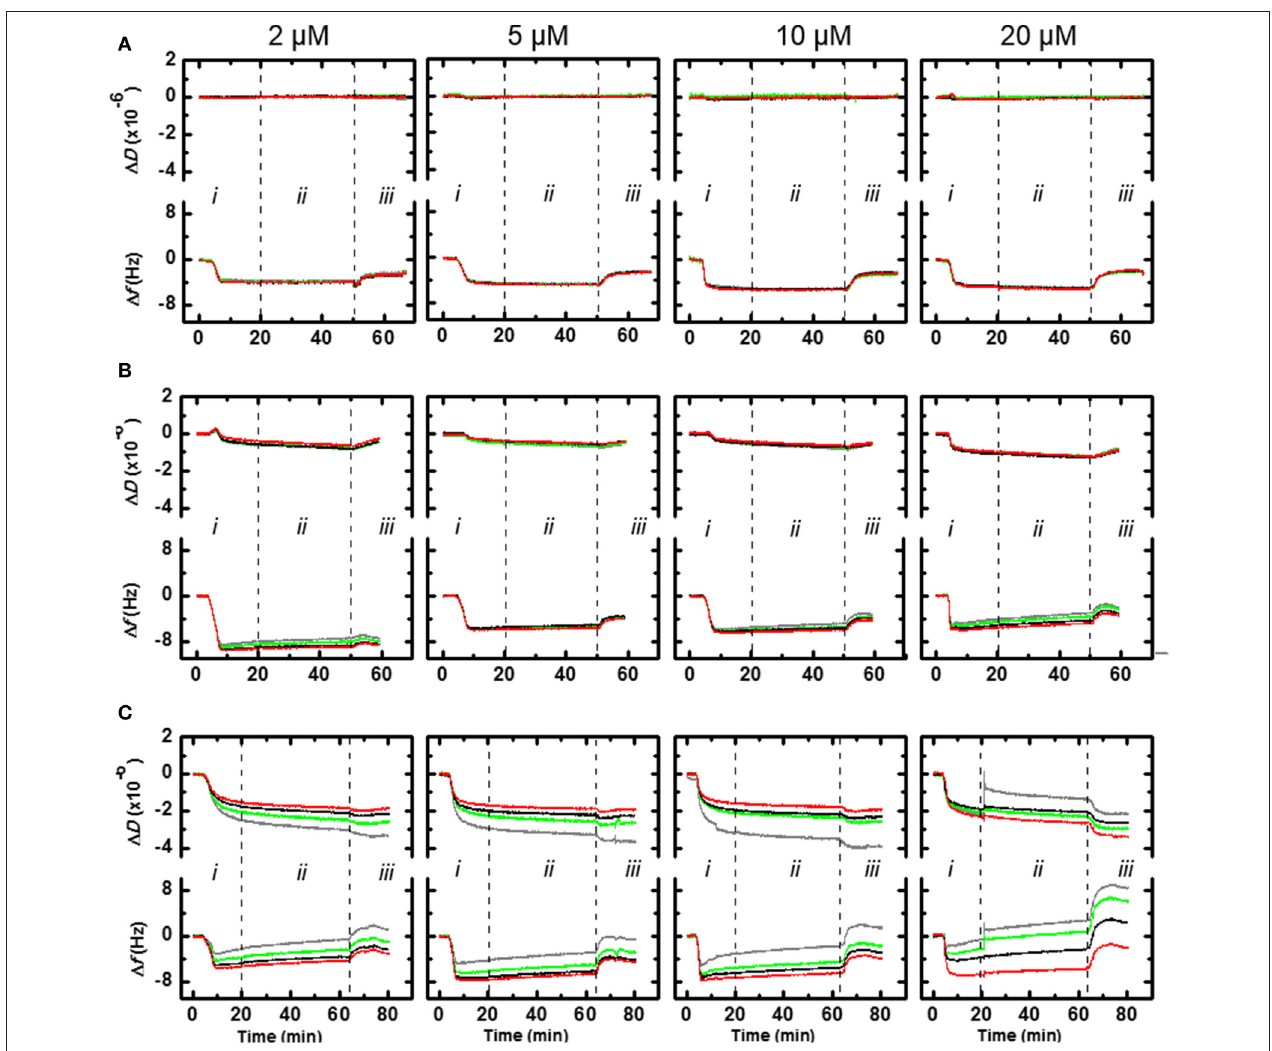
FIGURE 2 | QCM frequency and dissipation for Api137 (A), Api795 (B), and Api794 (C) acting on surfaces coated with DMPC:DMPG (4:1) as bacterial membrane mimics. Shown are normalized data as 1 D-t and 1 f -t graphs of 3rd (gray), 5th (green), 7th (black), and 9th (red) harmonics. Peptides were loaded into a flow cell (period i ), incubated (no flow) (period ii ), and PBS buffer introduced into the chamber (period iii